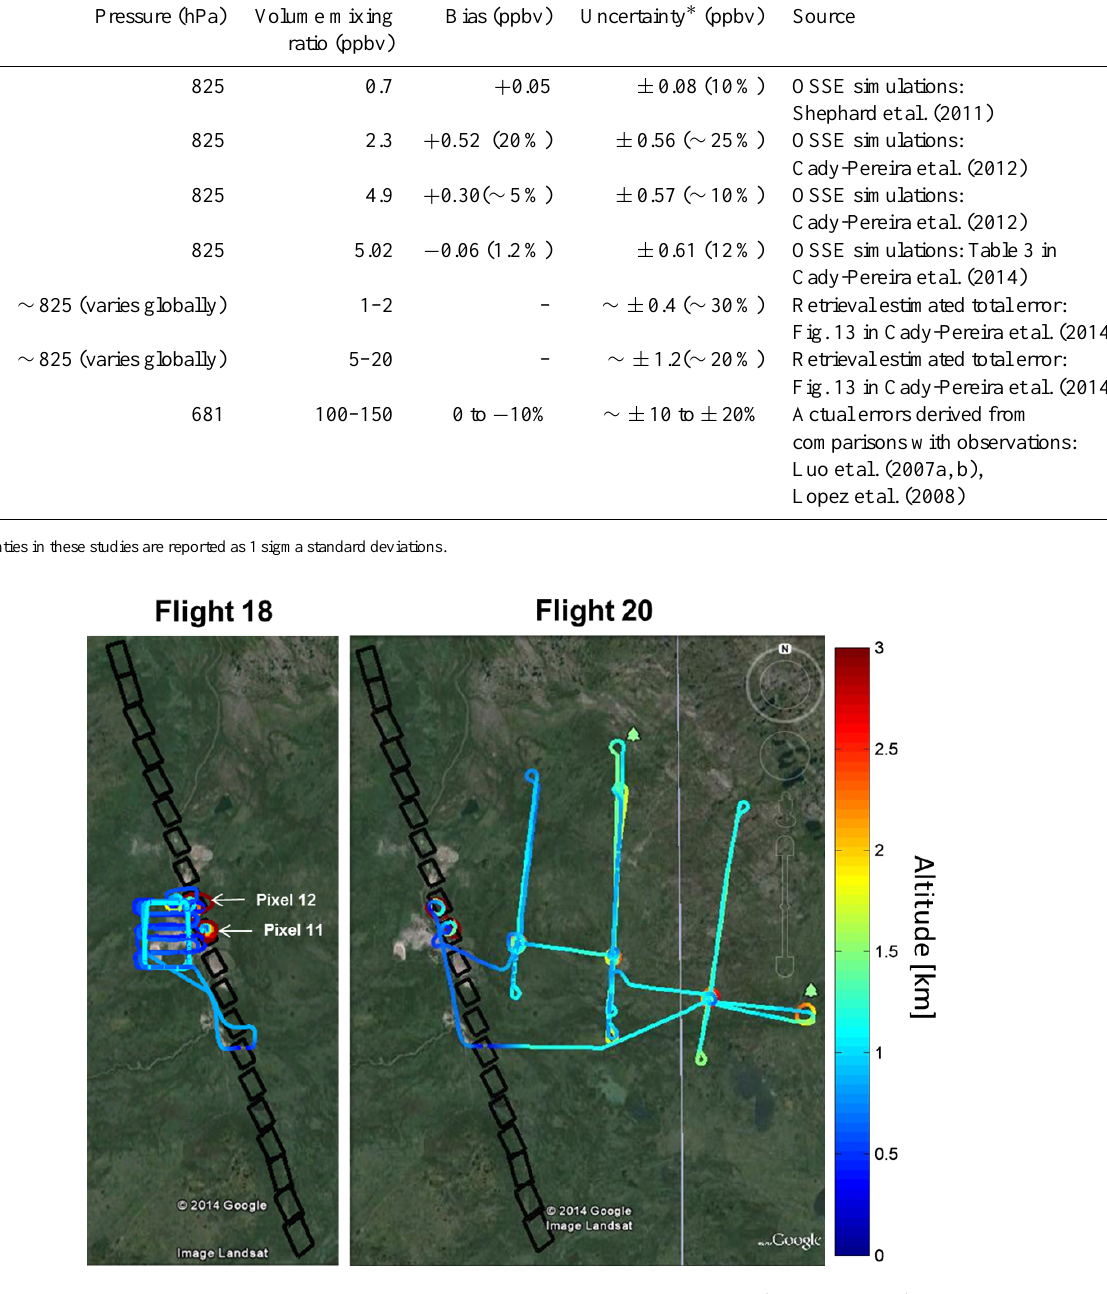
Figure 1. The aircraft flight tracks for flights 18 and 20 and the TES transect of 5 × 8km pixels (black polygons) spanning a total distance of ∼ 240km overplotted on Google Earth images. The aircraft flights are colour coded as a function of relative altitude going from the lower-altitude blue colours (from as low as 150m) to the higher-altitude red colours (reaching